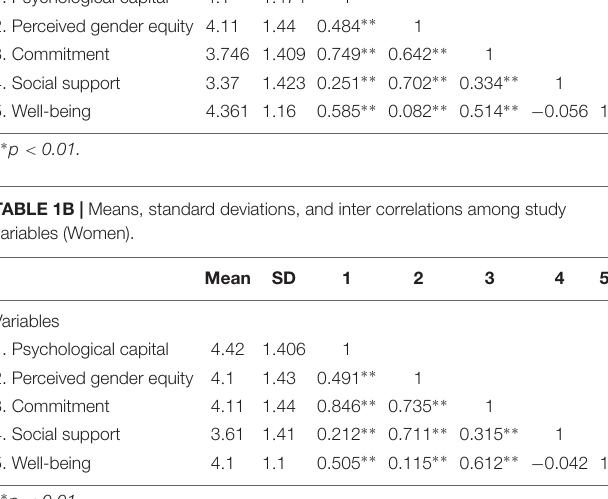
TABLE 1C | Means, standard deviations, and inter correlations among study variables (Men). Mean SD 1 Variables